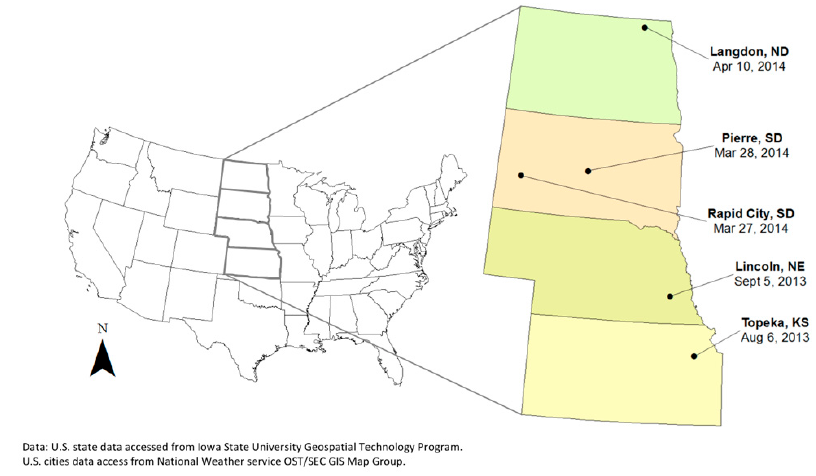
Figure 1. Locations and dates of farmer and ranchers focus group interviews exploring woody biomass potential in the U.S. Northern Great Plains.